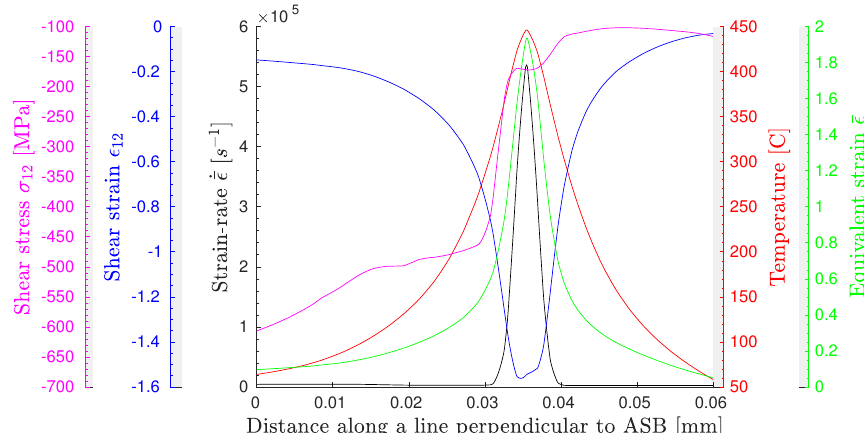
Figure 5. Distribution of state variables on a line approximately perpendicular to ASB: shear stress σ 12 , shear strain (cid:101) 12 , strain rate ˙¯ (cid:101) , temperature and equivalent strain ¯ (cid:101) ( v = 200 m/min, feed = 0.15 mm/rev, rake angle γ = 0 ◦